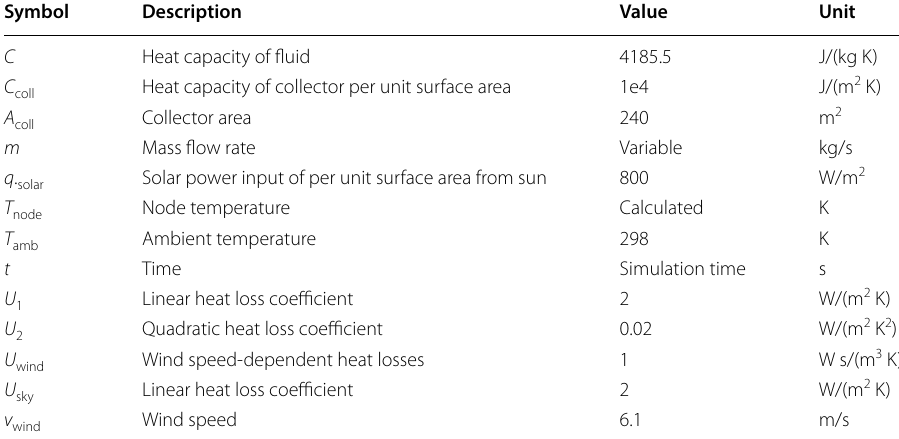
Table 1 Solar collector parameters [14] Symbol